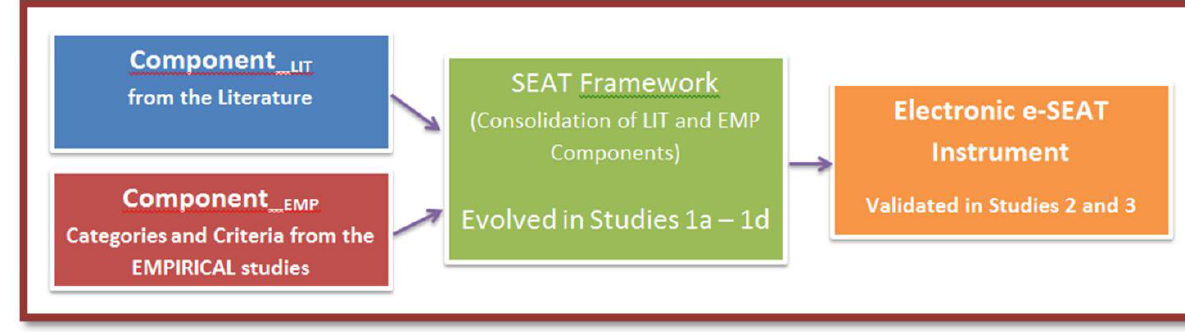
Figure 1. Evolution of SEAT and e-SEAT, adapted from Singh and de Villiers